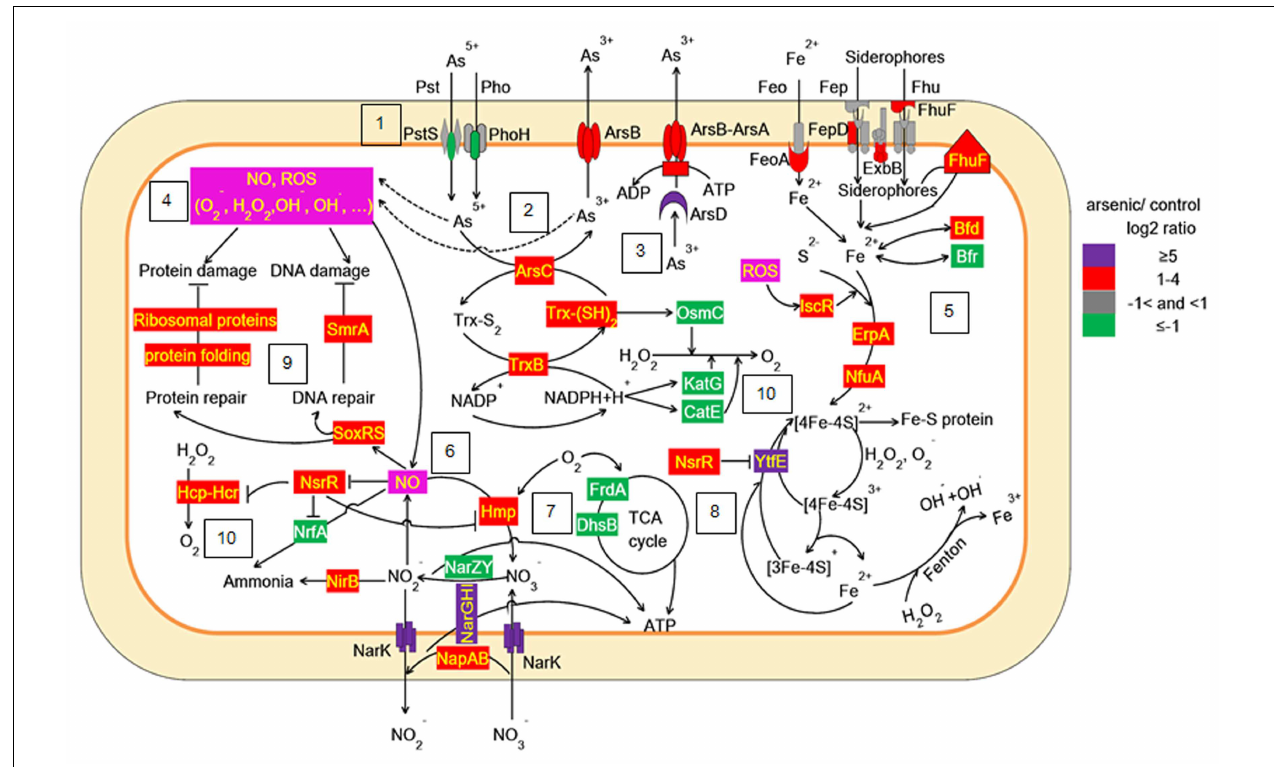
FIGURE 5 | Proposed scheme illustrating the toxicity and adaptive-response pathways of LSJC7 to As(V) stress. (1) As(V) influx pumps was down-regulation; (2) ArsC converted As(V) to As(III); (3) ArsB extruded As(III); (4) Arsenic induced ROS and NO generation; (5) ROS induced Fe–S clusters biogenesis and iron recruiting; (6) Endogenous NO up-regulated nsrR and hmp ; (7) Genes related to nitrate respiration and TCA cycle; (8) NO induced Iron–sulfur cluster repair and suppressed Fenton reaction; (9) SoxRS activated by NO might modulate DNA and protein repair; (10) Peroxiredoxins were